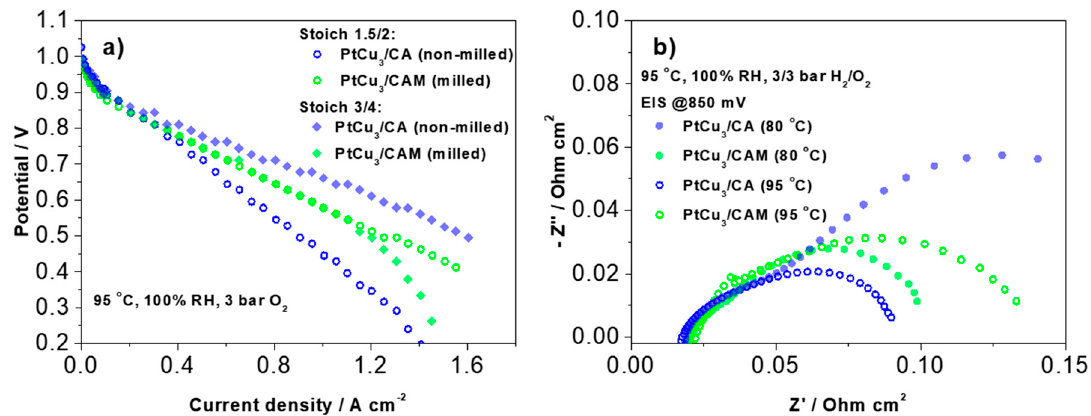
Figure 5. ( a ) Polarization curves for both PtCu analogues (PtCu 3 /CA and PtCu 3 /CAM; Pt load anode/cathode = 0.2 mg Pt cm − 2 ) at 95 °C, 100% RH, and 3/3 bar H 2 /O 2 pressure and stoichiometry H 2 /O 2 of 1.5/2 and 3/4. ( b ) Single cell impedance spectra with non-milled PtCu 3 /CA and milled PtCu 3 /CAM catalyst at 80 and 95 °C (850 mV). Circles: measured EIS spectra (units: Ohm).